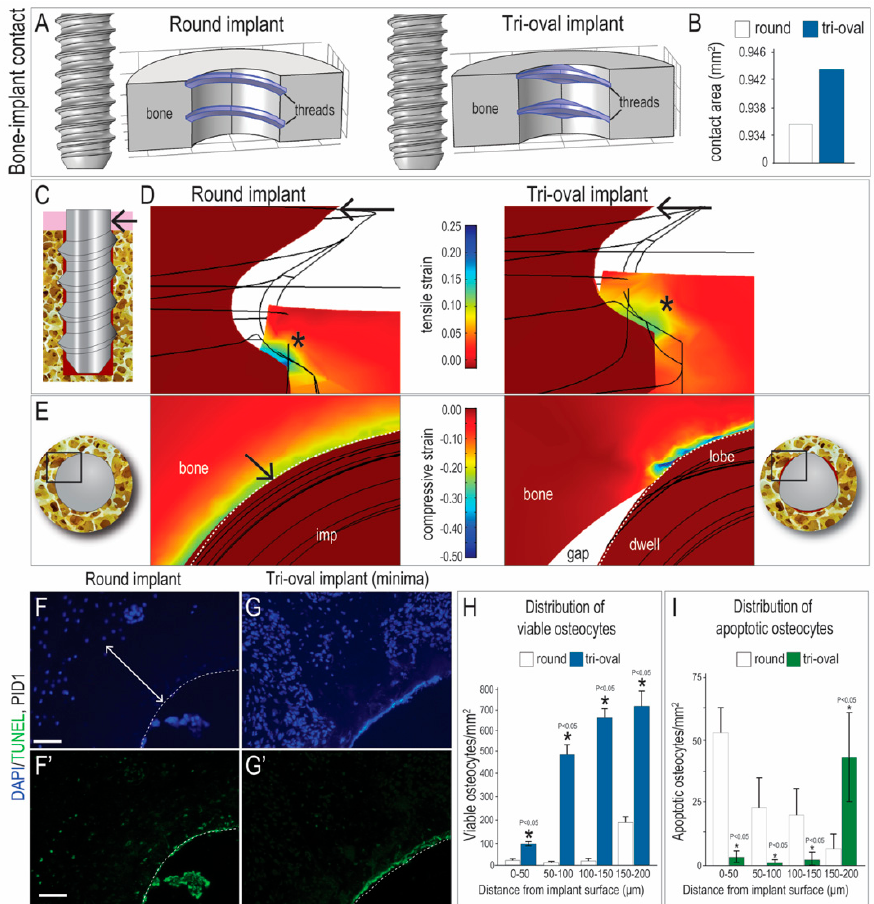
Figure 2. Compared to a round implant, the minima of a tri-oval implant are associated with significantly lower strains and a significantly smaller zone of osteocyte death. ( A ) FE modeling of round (left) and tri-oval (right) implants in bone, using CAD files of the actual implants used in vivo. In a transverse plane, the threads of each type of implant (blue) penetrate the bone, which is modeled as a solid material. ( B ) The calculated bone-implant contact area due to thread penetration. ( C ) Formulation of a FE model of laterally-loaded implant in bone. ( D ) Peri-implant strains surrounding laterally-loaded round and tri-oval implants in the sagittal plane. ( E ) Peri-implant strains arising from initial misfit of the round and tri-oval implants as seen in the transverse plane; only the maxima of the tri-oval implant penetrate the bone. ( F ) DAPI staining of interfacial bone surrounding a representative round implant and ( G ) a representative tri-oval implant; white arrow denotes a circumferential osteocyte-free zone and dotted white line demarcates the osteotomy edge. ( F’ , G’ ) TUNEL staining on adjacent tissue sections. Quantification of the distribution of ( H ) viable and ( I ) apoptotic osteocytes as a function of distance from implant. Abbreviations: imp, implant; PID, post-implant day. Scale bars = 50 µm.